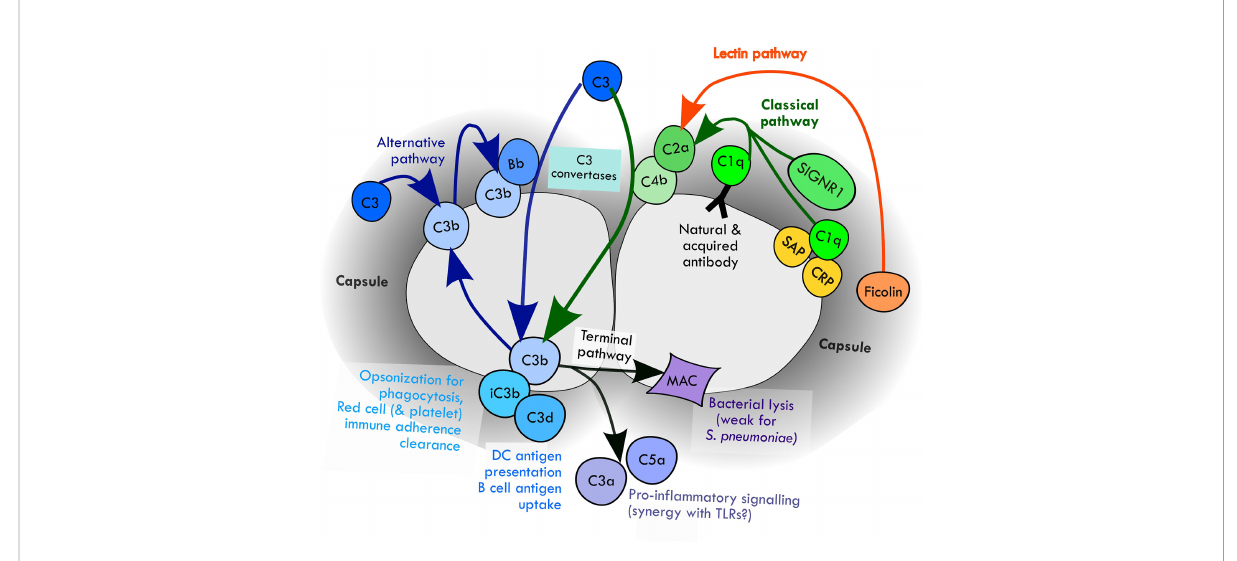
FIGURE 1 Mechanisms of activation of complement pathways by S. pneumoniae and the downstream potential effects on the immune